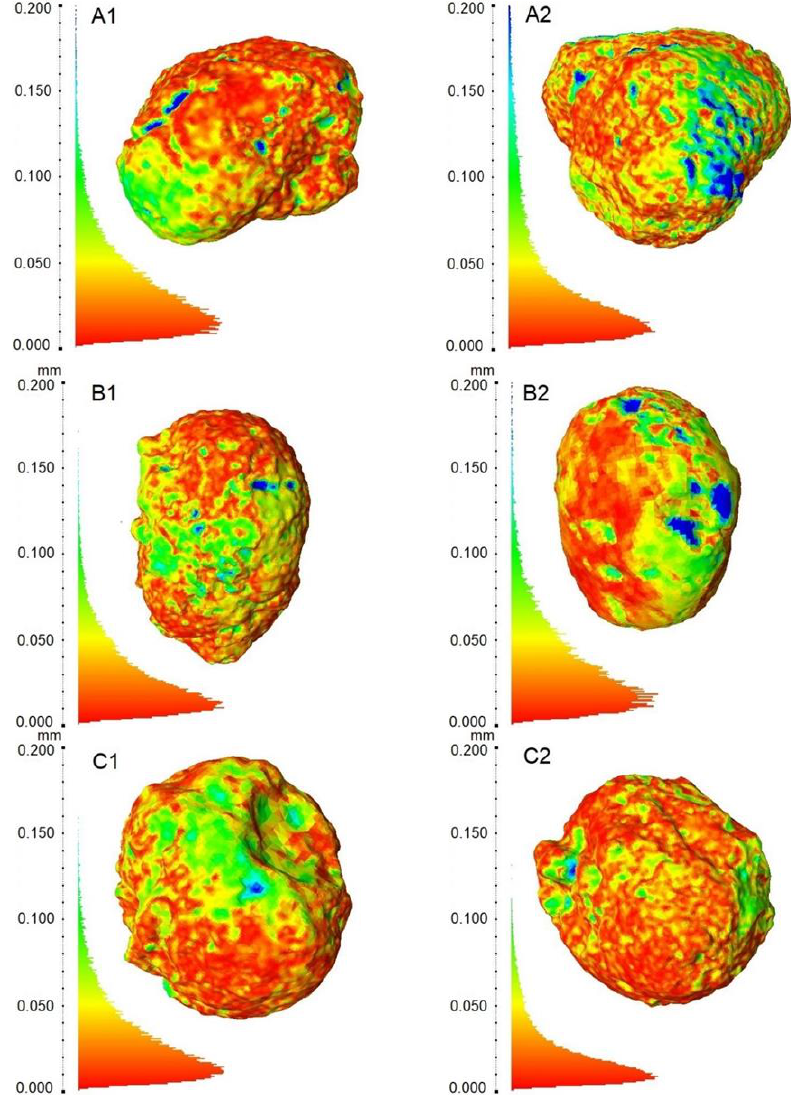
Figure 6. Difference between the CT-based and photogrammetry-based models measured as the Hausdorff distance (area-weighted histograms and error distribution on the grain surfaces) for samples ( A1 – C2 ).